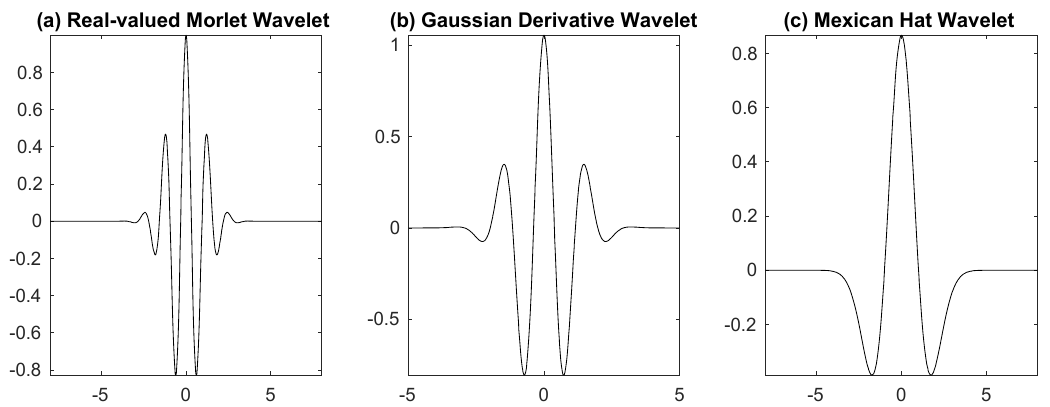
14 of 30 Figure 9. Infrared (IR) image snapshot, showing the areas that were placed while calculating the spatial medians of temperature data over time for the four defective areas (D2, D3, D4, and D5) and the selected sound area (S). 5.2. Wavelet ‐ Based Approach The choice of an appropriate mother wavelet in the CWT analysis is generally made based on the data (or image) characteristics and the intended application, but it is optimized by its ability to obtain meaningful results [79]. In applications concerning condition monitoring, different mother wavelets (with different time ‐ frequency structures) can be implemented, such as the Haar, Meyer, Morlet, Gaussian, and Mexican